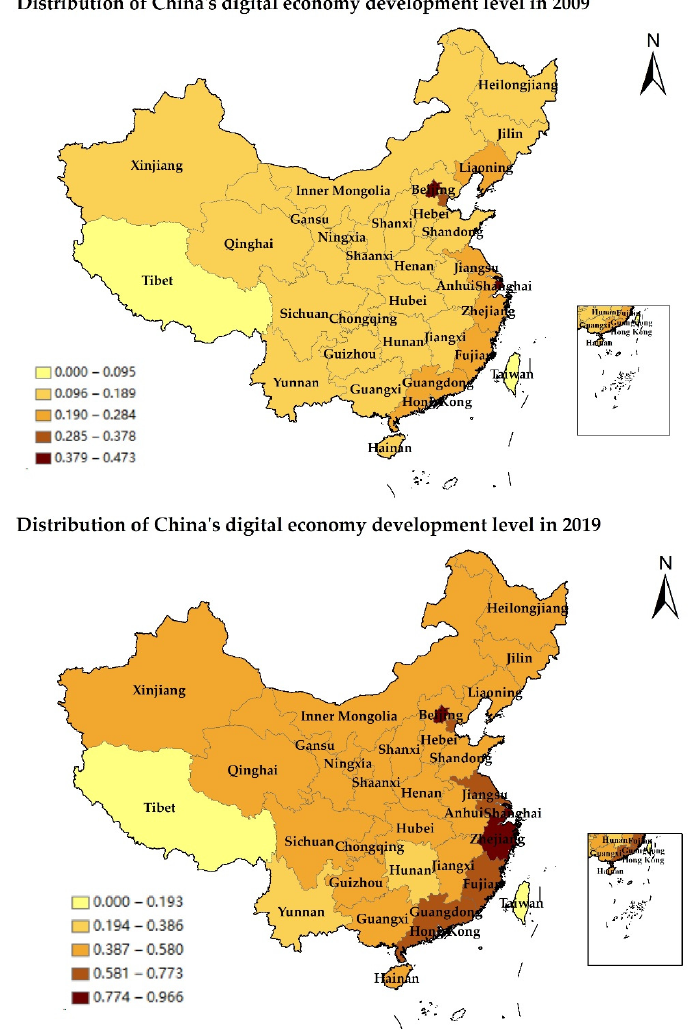
Figure 3. Comprehensive Index of the Level of Digital Economy Development of China’s Provinces in 2009 and 2019. Note: The original data was obtained from China Statistical Yearbook, China In- formation Yearbook, China Information Society Development Report, China Electronic Information Industry Yearbook, and China Science and Technology Statistical Yearbook and later measured.